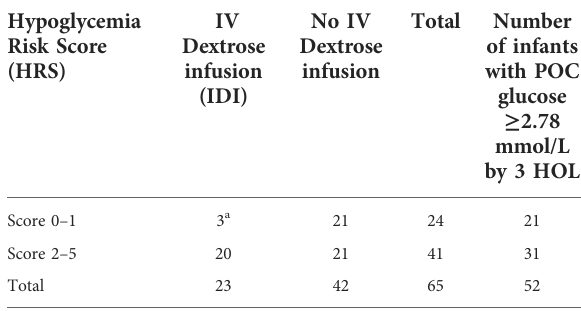
TABLE 2 Demographic characteristics of study infants and mothers ( n =65).